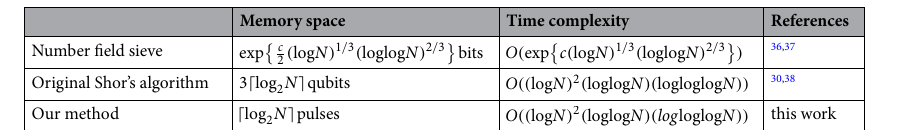
Table 1. Complexity comparison of number field sieve, Shor’s algorithm and our method for factoring N .